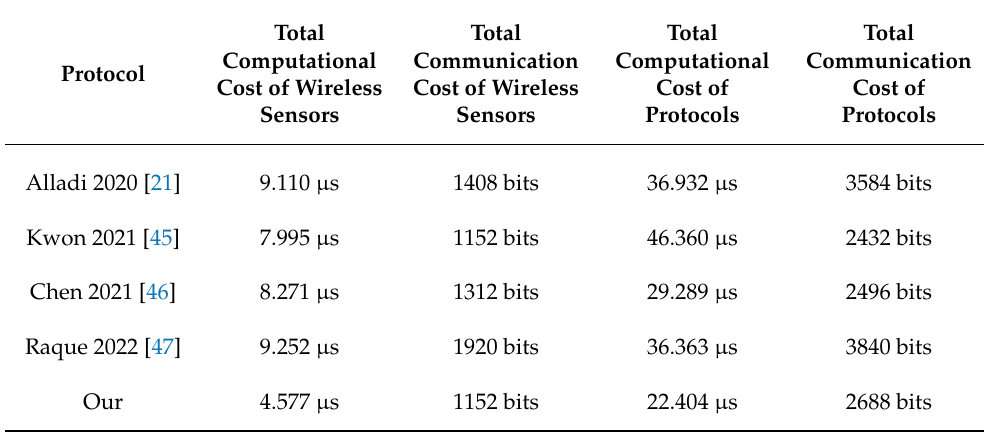
Table 3. Overall performance of the